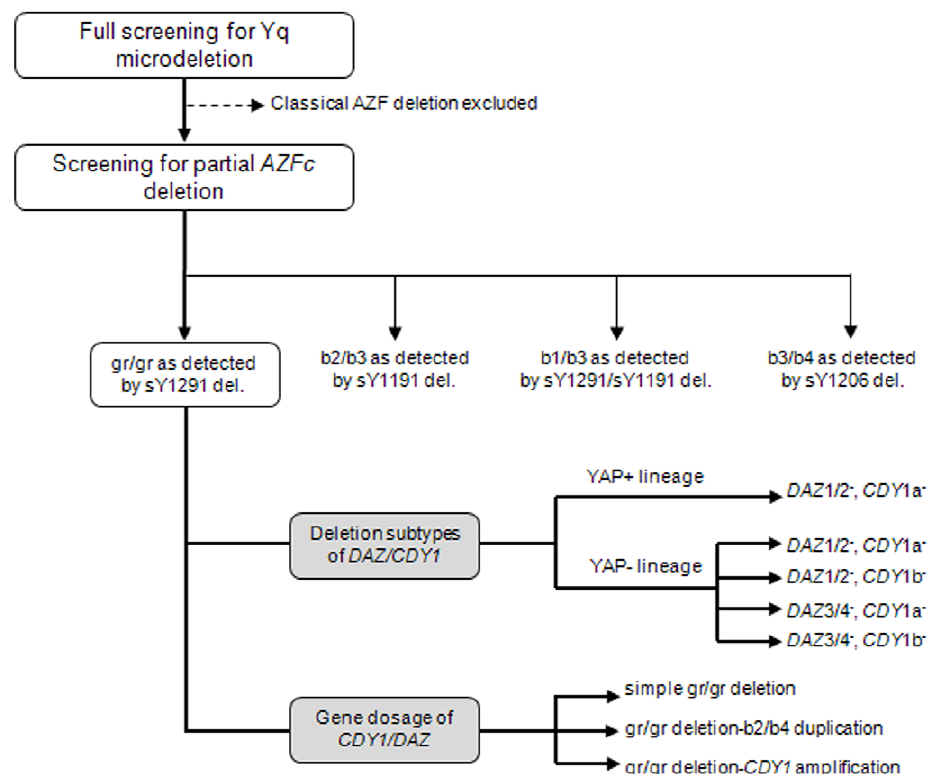
Figure 1. Analysis scheme.